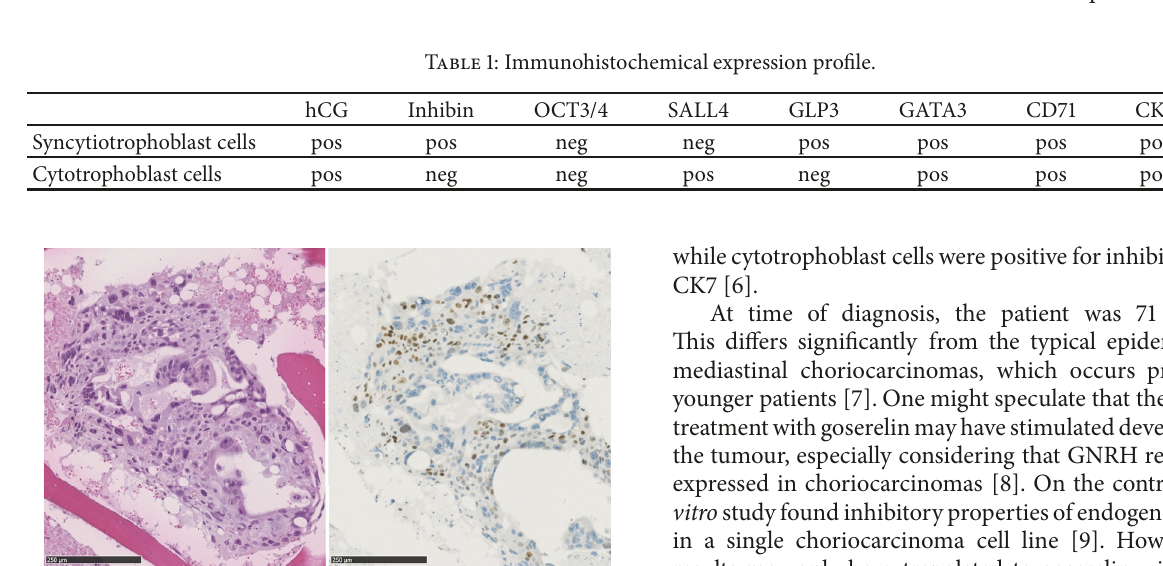
showed binary expression of diagnostic markers (Table